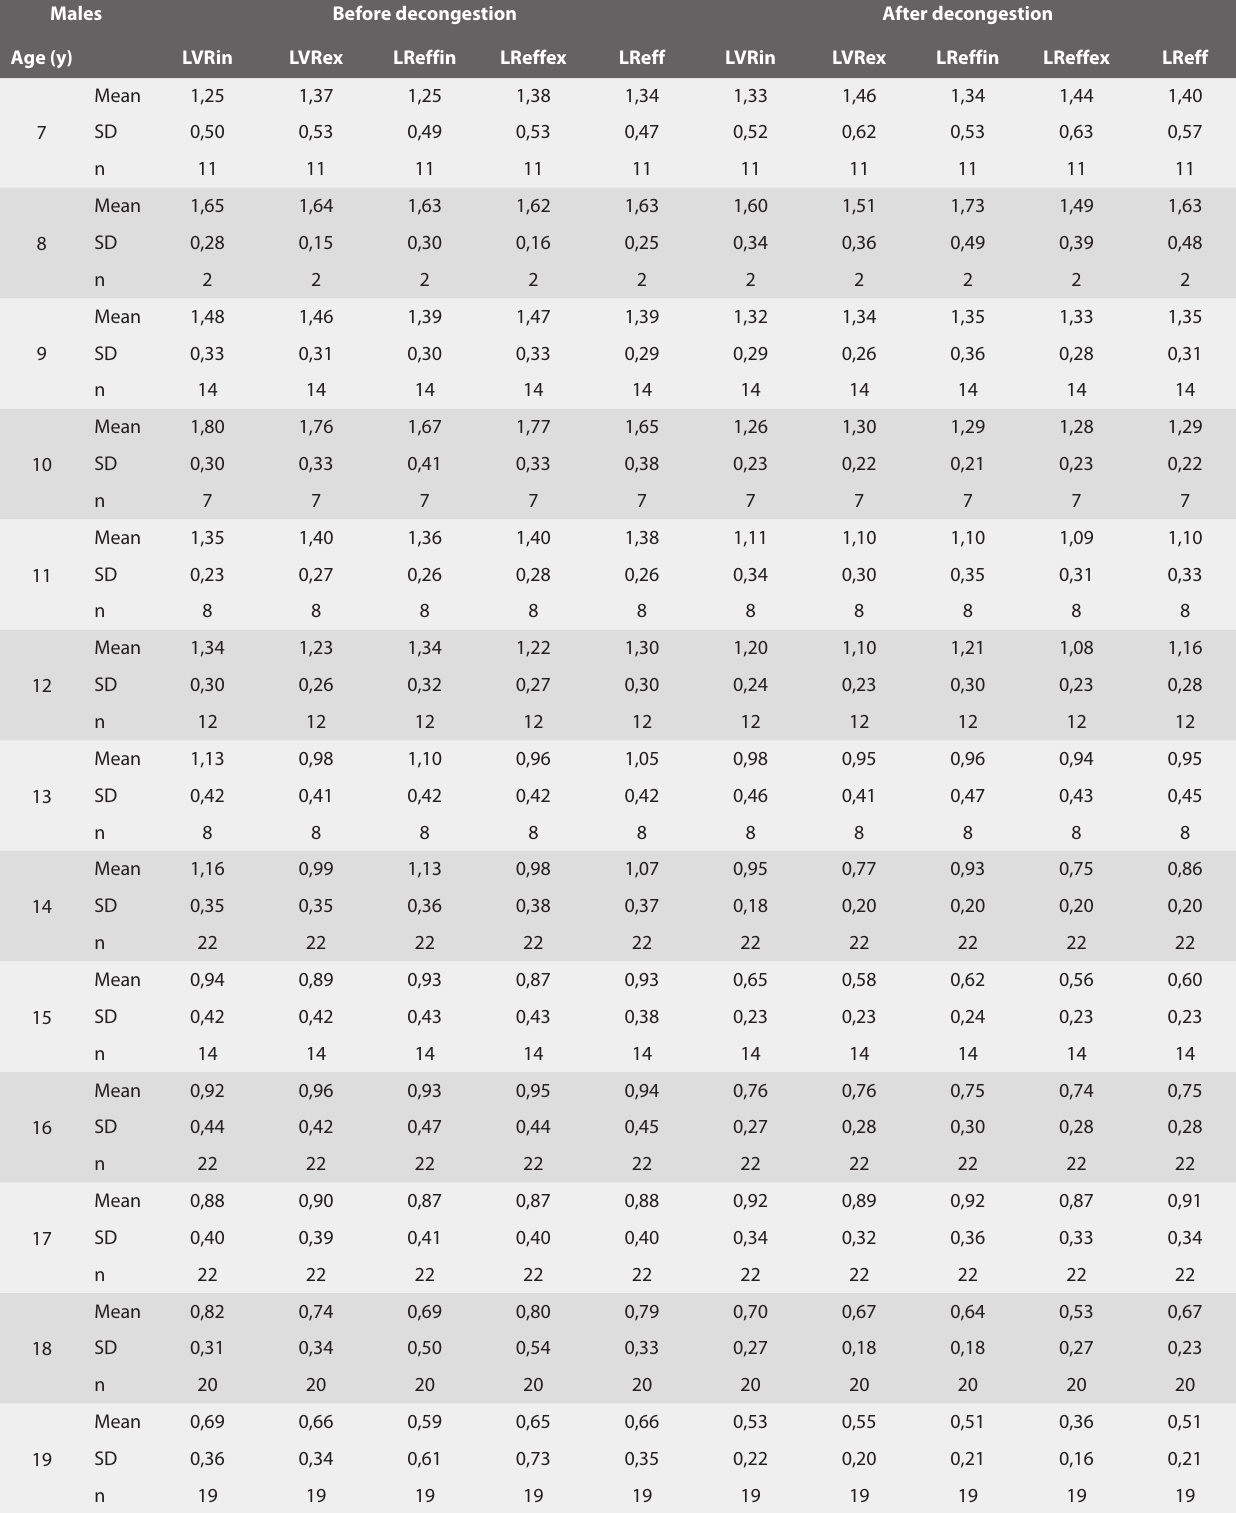
Table 3A. Descriptive statistics for resistances at different ages in